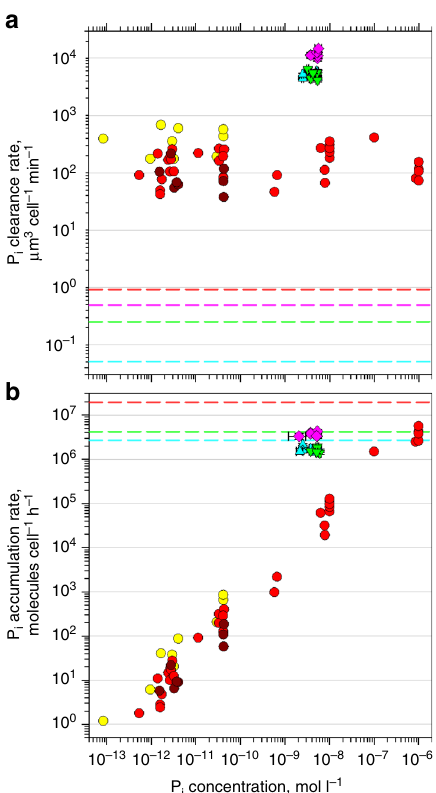
Fig. 2 P i acquisition rates of oceanic and cultured cells. a Comparison of cellular P i clearance rates of oceanic SAR11 (light blue triangles, n = 14), Prochlorococcus (green triangles, n = 11) and Synechococcus (pink diamonds, n = 7) at ambient P Synechococcus i concentrations with rates of cultured strains WH7803 (yellow circles, n = 10), WH8102 (red circles, n = 35) and WH8109 (brown circles, n = 8) across a wide range of P i concentrations. b Comparison of maximal cellular P i accumulation rates of the same bacteria (SAR11 n = 12, Prochlorococcus n = 7, Synechococcu n = 7, WH7803 n = 10, WH8102 n = 35 and WH8109 n = 8). Dashed lines indicate corresponding ( a ) cellular volumes ( µ m 3 cell − 1 ) and ( b ) cellular phosphorus content (P atoms cell − 1 ) of oceanic SAR11 (light blue), Prochlorococcus (green), Synechococcus (pink) and cultured Synechococcus sp. WH8102 (orange). Horizontal grey lines indicate major ticks of the logarithmic Y-axis to assist comparing values. Symbols present individual measurements for cultured Synechococcus cells and mean values of four sorting replicates for oceanic bacteria; error bars indicate corresponding SD. The full range of rates of oceanic bacteria is shown in Supplementary Fig. 2. Source data are provided as a Source Data fi